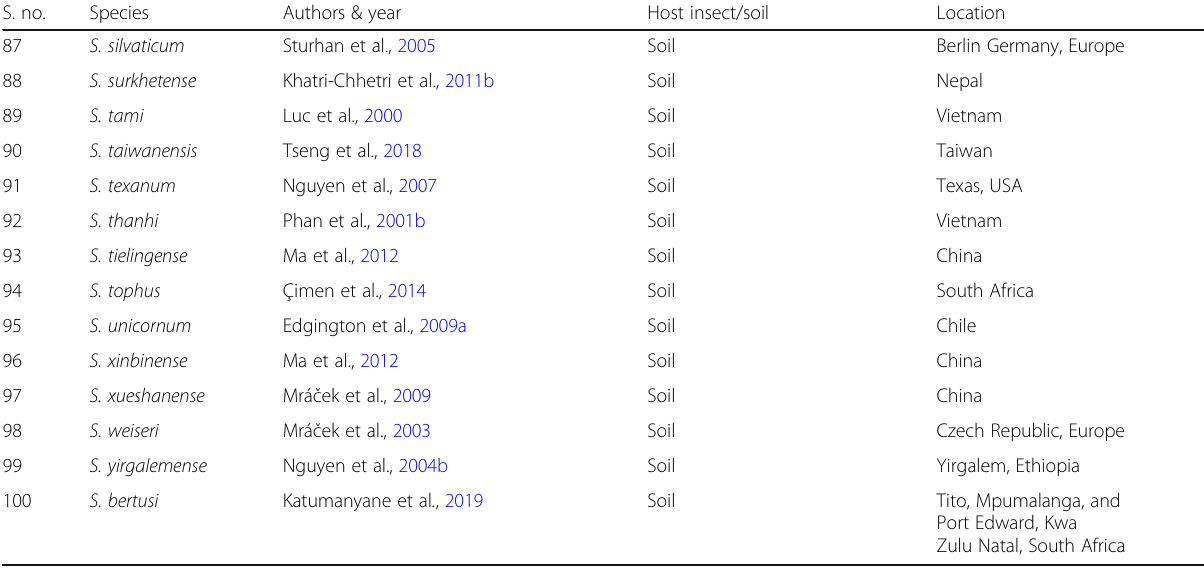
Table 1 List of Steinernema species recorded from different countries of the world (Continued) S. no.